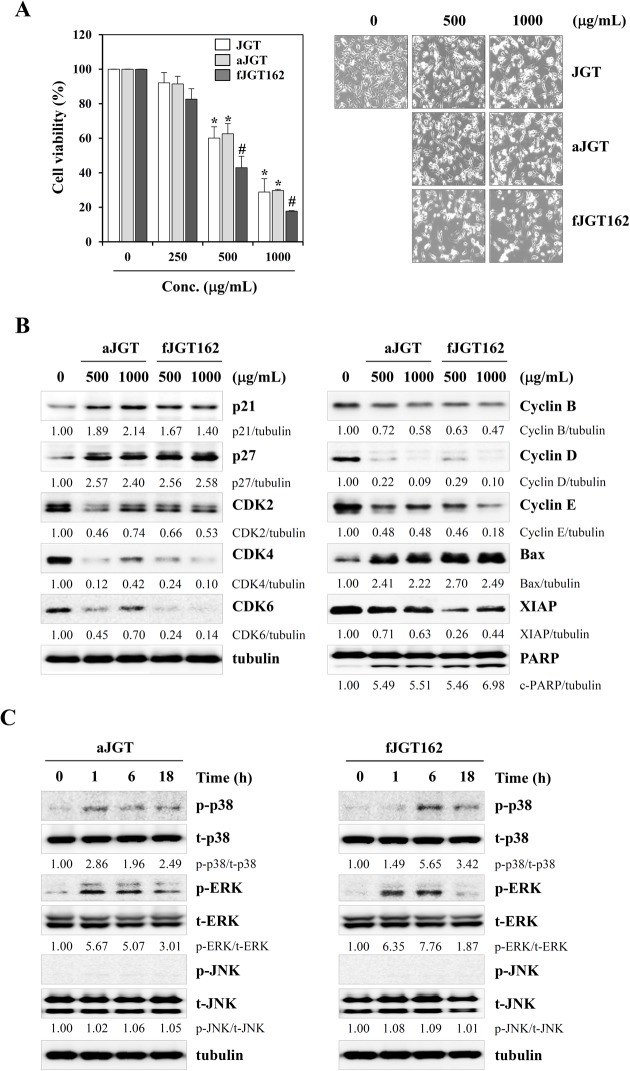
aJGT and fJGT162 induce cell death and activate p38/ERK.
(A) HT1080 cells were treated with the indicated concentrations of aJGT or fJGT162 for 48 h, and cell viability was evaluated using MTT assays and cell morphology was observed under an inverted microscope. Data are representative of three independent experiments performed in triplicate and are expressed as means ± SD. * p < 0.05 vs. untreated control, # p < 0.05 vs. JGT or aJGT. (B) The levels of cell cycle- and cell death-related proteins in aJGT- or fJGT162-treated HT1080 cells were examined by Western blotting 48 h post-treatment. (C) The activation of MAPKs was analyzed by Western blotting after aJGT or fJGT162 treatment for 1, 6, and 18 h. The band intensities relative to those of untreated cells were calculated after normalization to tubulin expression.